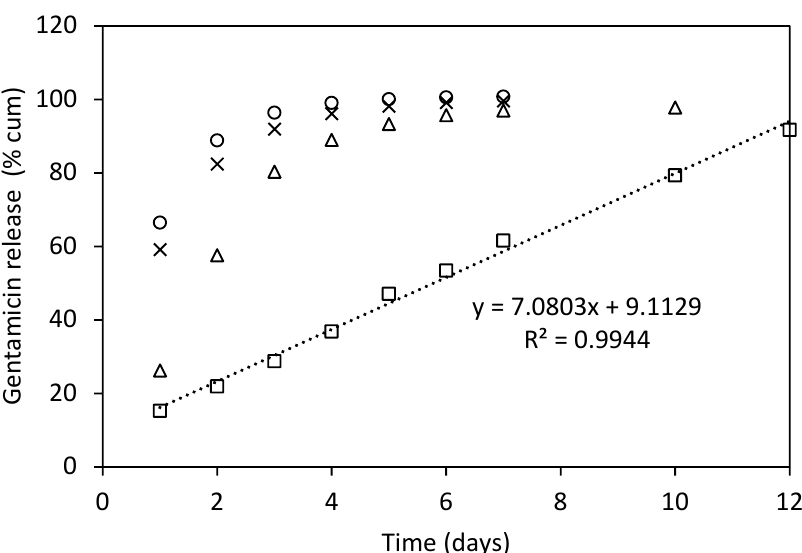
Figure 8. Gentamicin sulphate releases from bone graft impregnated with an aqueous solution (circle), a hypromellose gel (cross), a water-in-oil emulsion (triangle), and a PLGA solid dispersion (square).